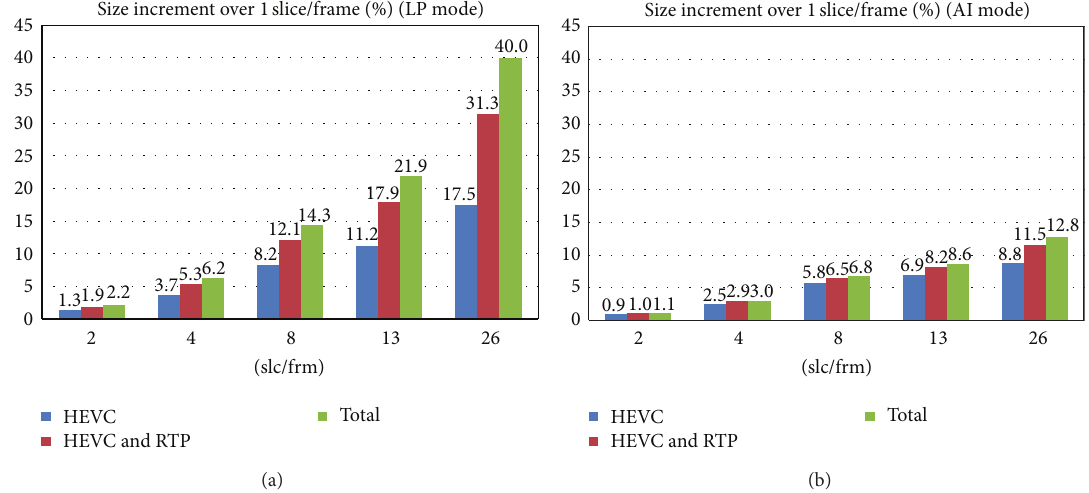
Figure 2: Percentage of bitrate increase (without FEC protection) for different number of slices per frame. (a) LP mode. (b) AI mode. (HEVC raw bitstream//HEVC + RTP header//HEVC + RTP header + fragmentation header.)